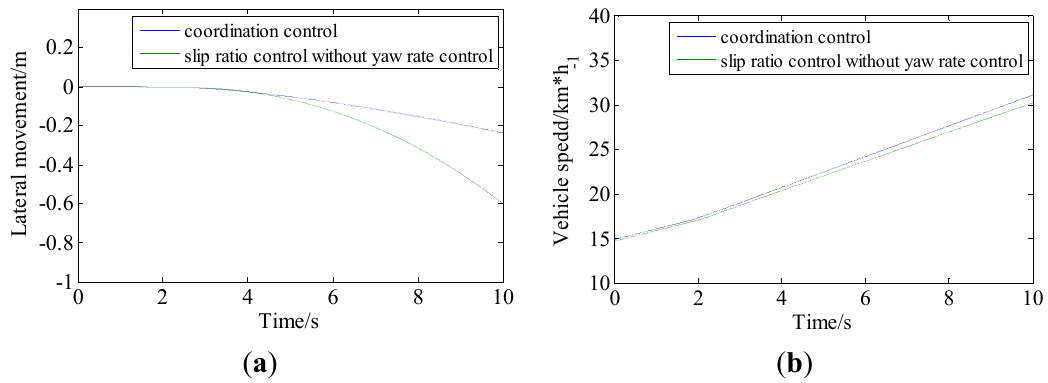
Figure 9. Comparison of simulation results of proposed strategy and normal strategy on low friction road: ( a ) lateral movement and ( b ) acceleration performance.